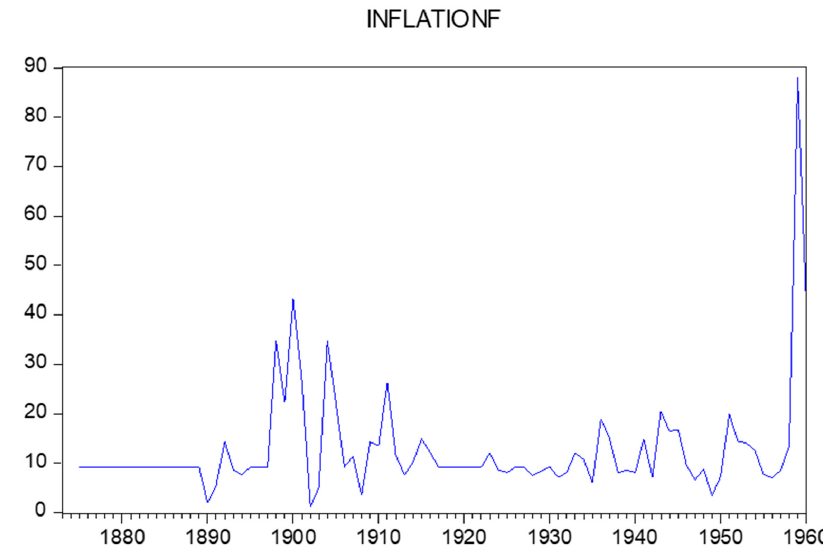
Figure 8. Predictions of inflation rates for 1873 to 1960.